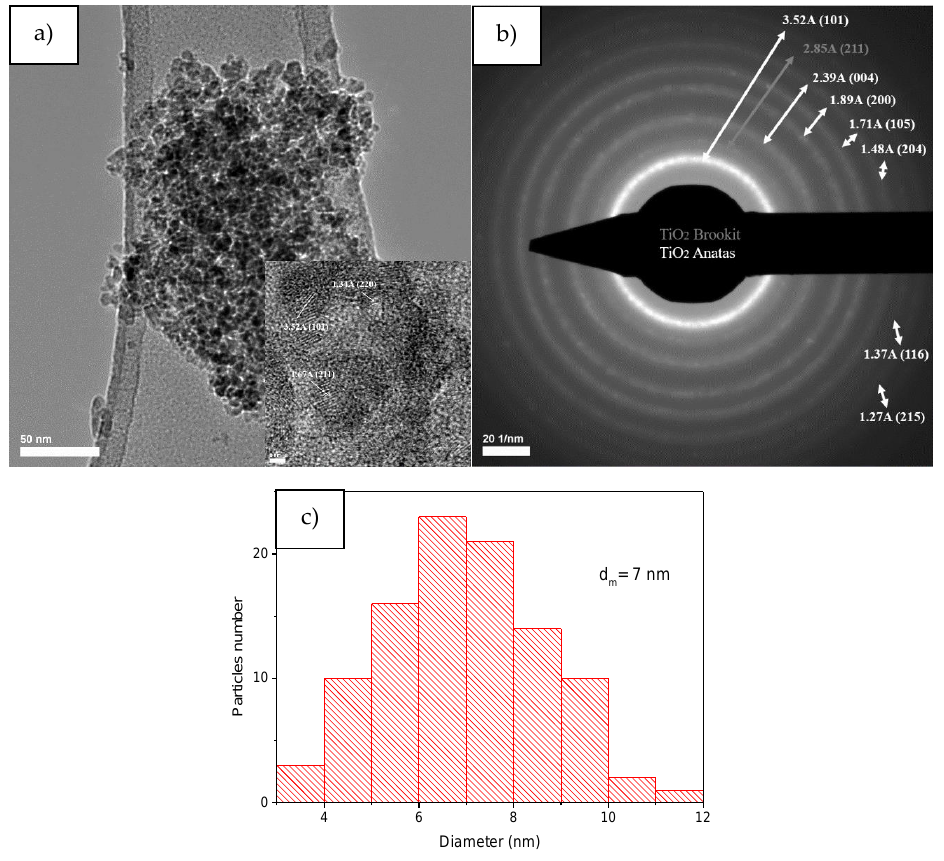
Figure 9. The TEM and HRTEM images ( a ), SAED patterns ( b ) and particle size distribution ( c ) corresponding to TiO 2 @Fe SG sample.